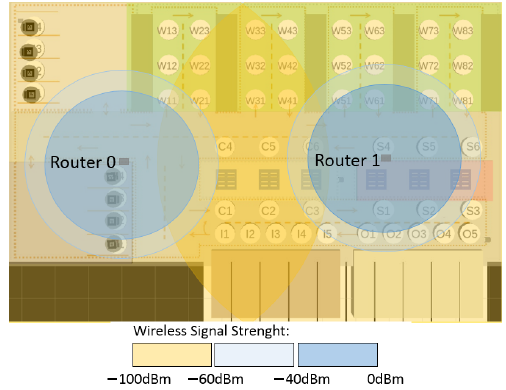
Figure 7. Wi-Fi signal coverage from two